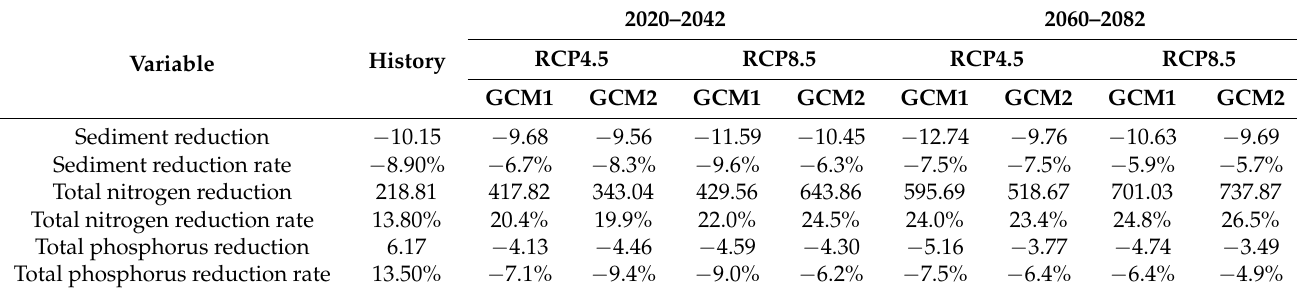
Table 6. Reduction of NPS pollution loads by land use change of ecological protection without the consideration of spatial allocation scenario.